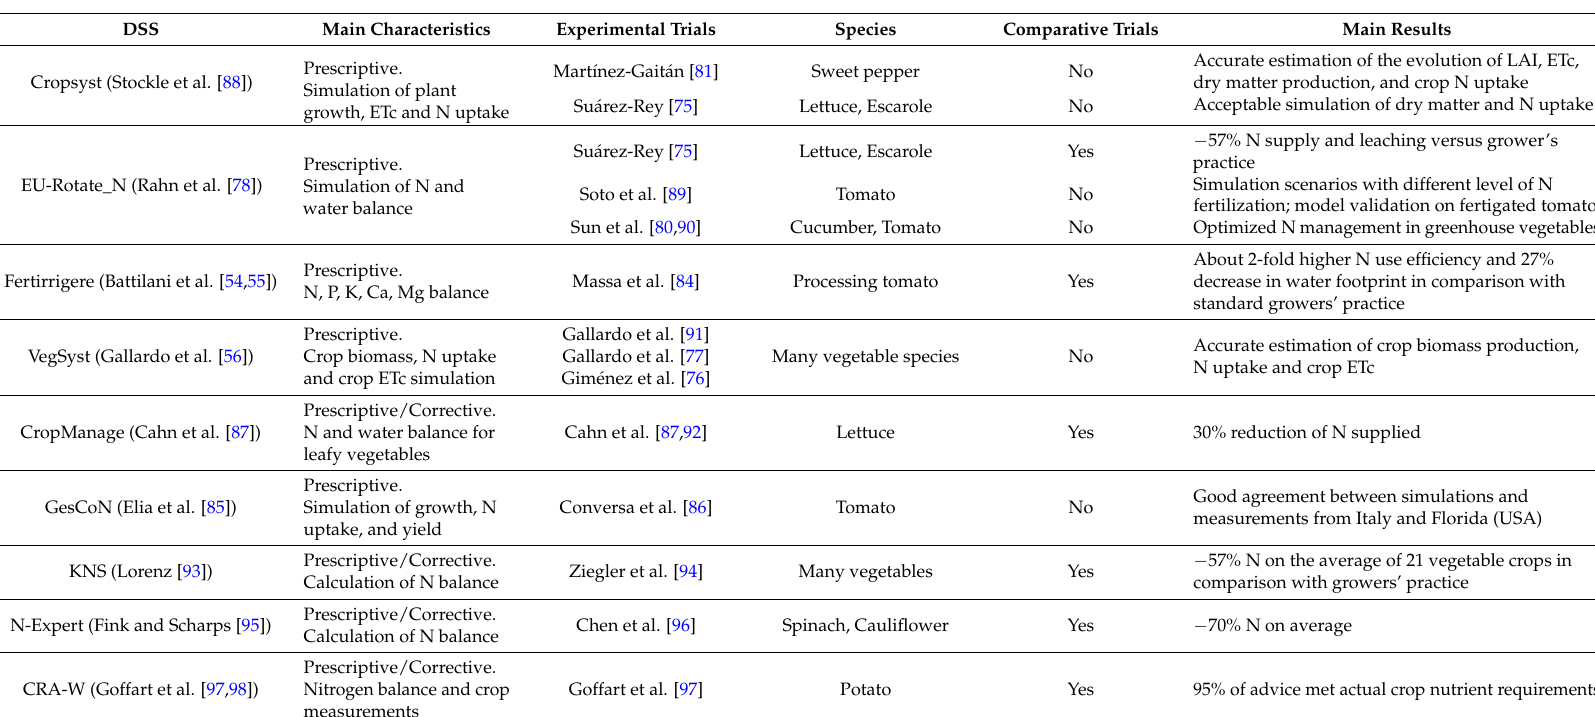
Table 3. The main Decision Support Systems (DSSs) for fertigation management. For each DSS, the reference of the inventor(s), the main input and output, and the eventual validation work of the model are